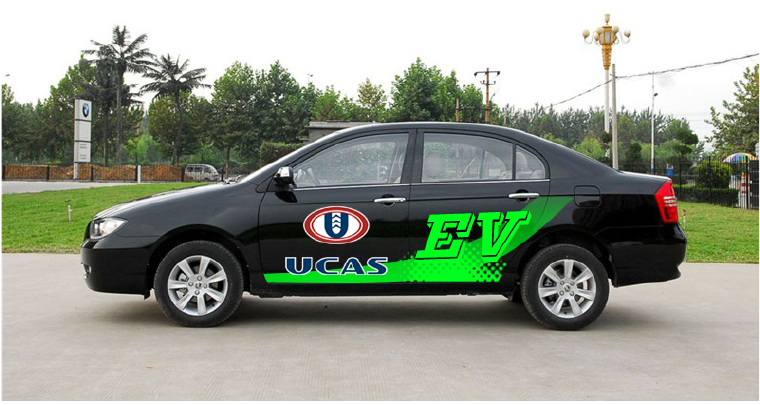
Figure 1. LF620 prototype EV.